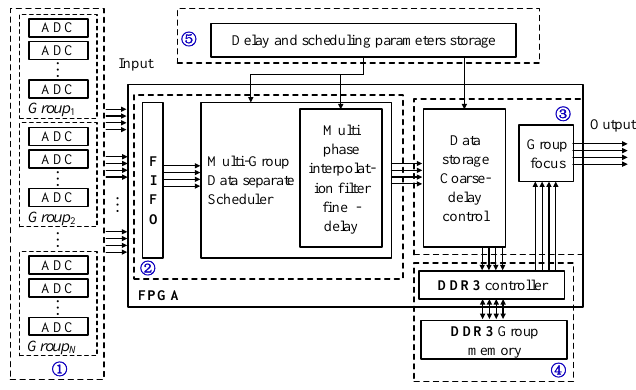
Figure 1. Diagram of the fine delay module for multi-group scanning.